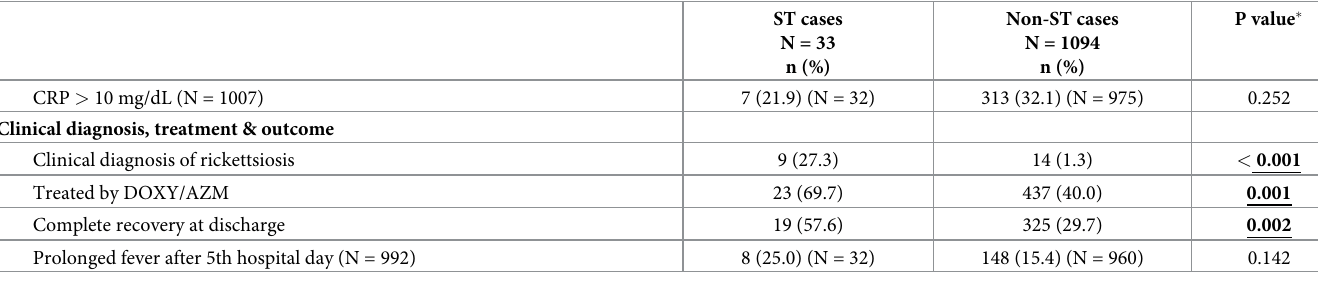
rank-sum test for other continuous variables. �� altered mental status [Glasgow coma scale <